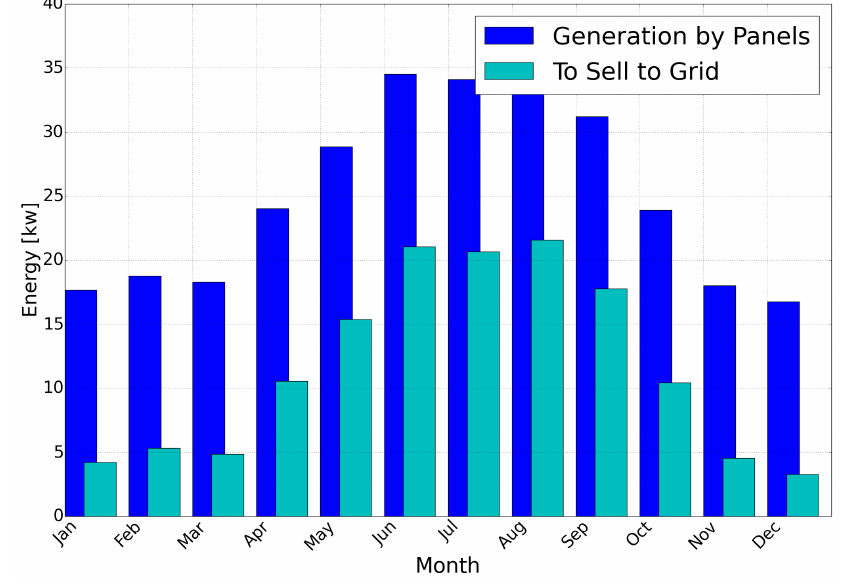
Figure 10. Monthly energy generation in